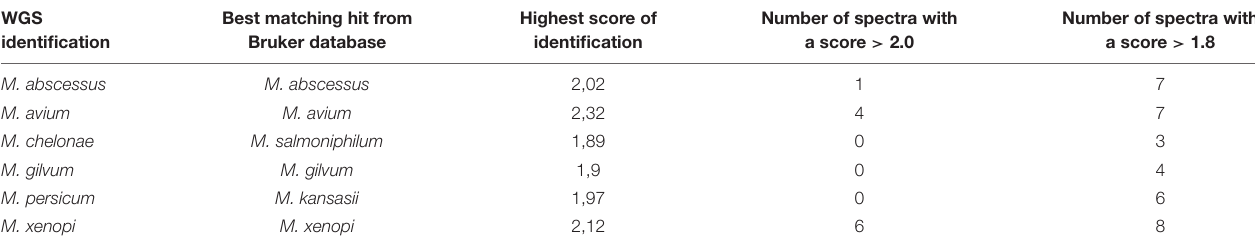
TABLE 3 | Negative control isolate identifications compared with the Bruker Mycobacteria beads method MALDI-TOF